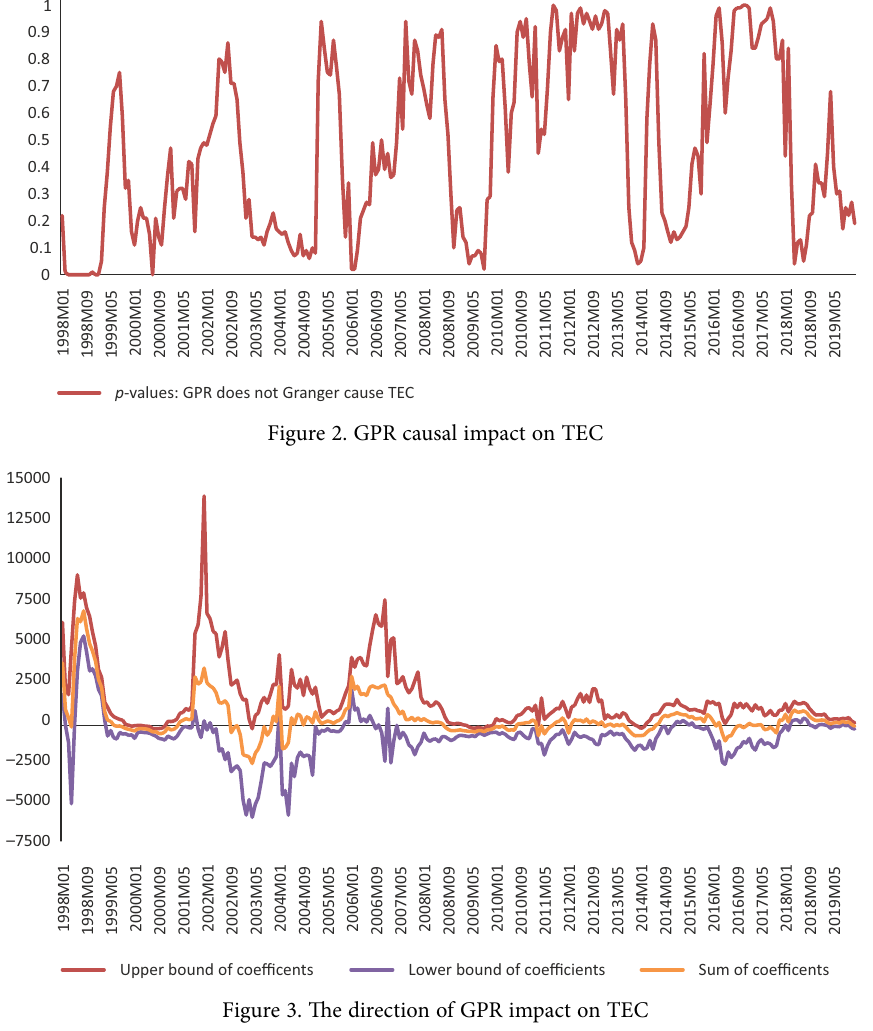
Figure 3. The direction of GPR impact on